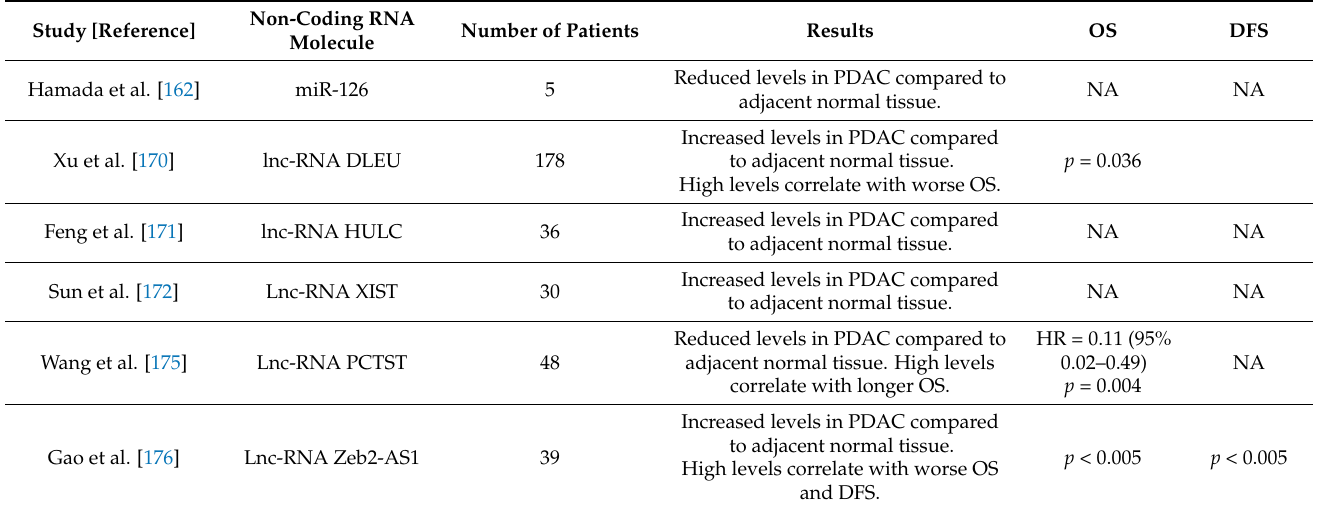
Table 3. Studies showing the expression levels of non-coding RNA molecules in PDAC patients compared to adjacent normal tissue and their correlation with prognosis. PDAC: pancreatic ductal adenocarcinoma; HR: hazard ratio; CI: confidence interval; NA: not